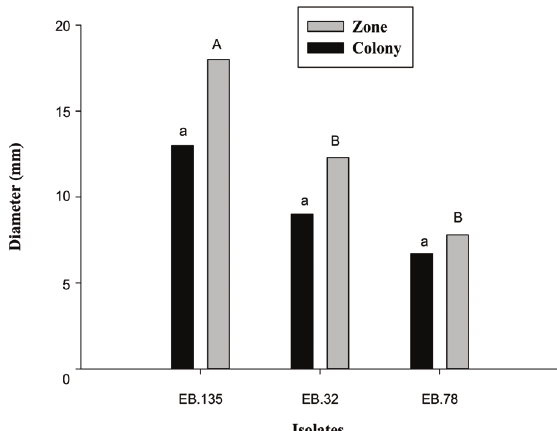
Figure 2 - Average colony (colony Ø) and phosphate solubilization zone (zone Ø) diameters in NBRIP medium supplemented with soy lecithin for endophytic bacteria isolated from “Prata Anã” banana tree roots. Data are in mm. (Vertical bars represent the standard error). The means followed by the same upper and lower case letters indicate they belong to the same group through the Scott-Knott test at a significance level at P < 0.05.